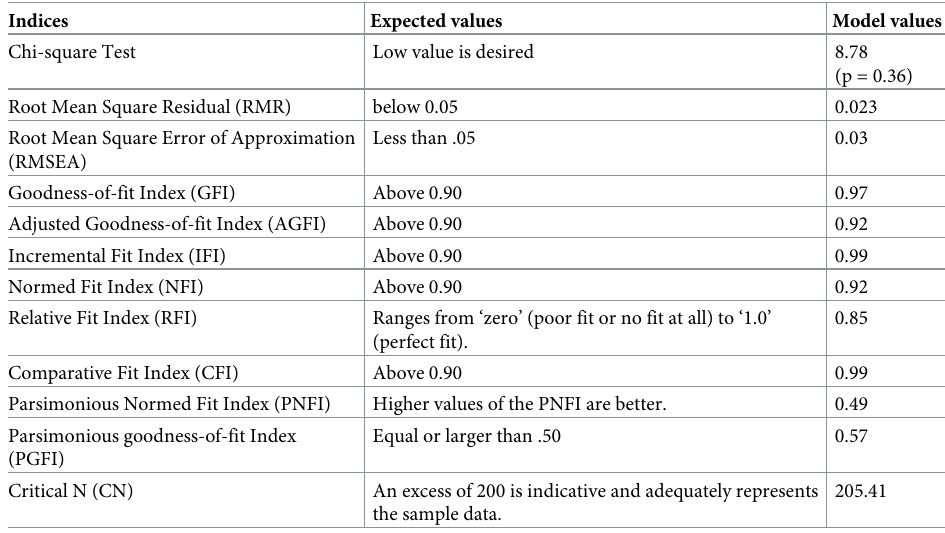
Table 5. Values of model fit indices in SEM to the